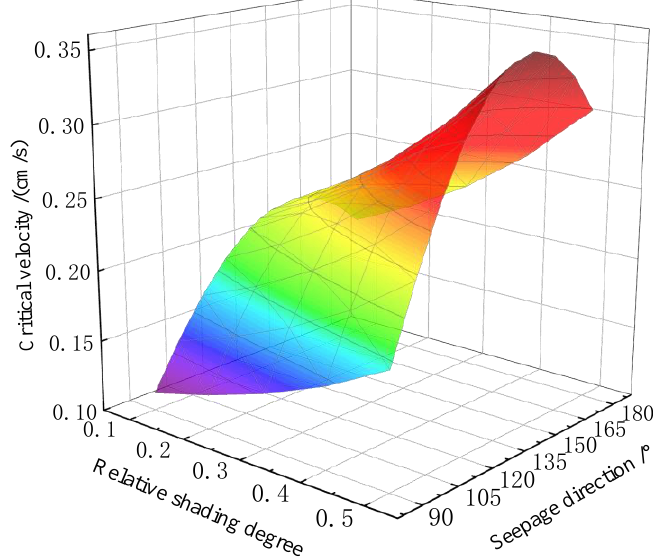
Figure 10. Effect of the relative hidden degree on the critical velocity.